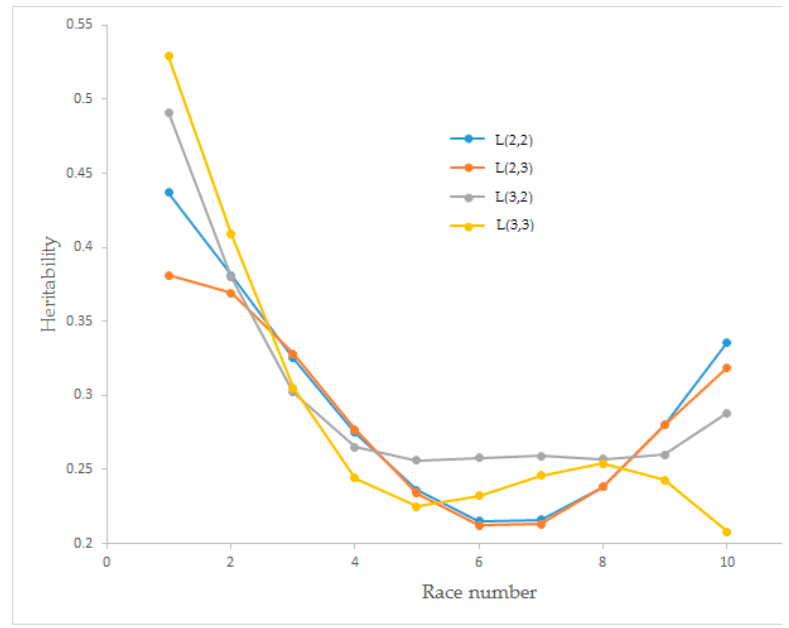
Figure 4. Estimation of heritability values for race speed from different orders of Legendre polynomial models.